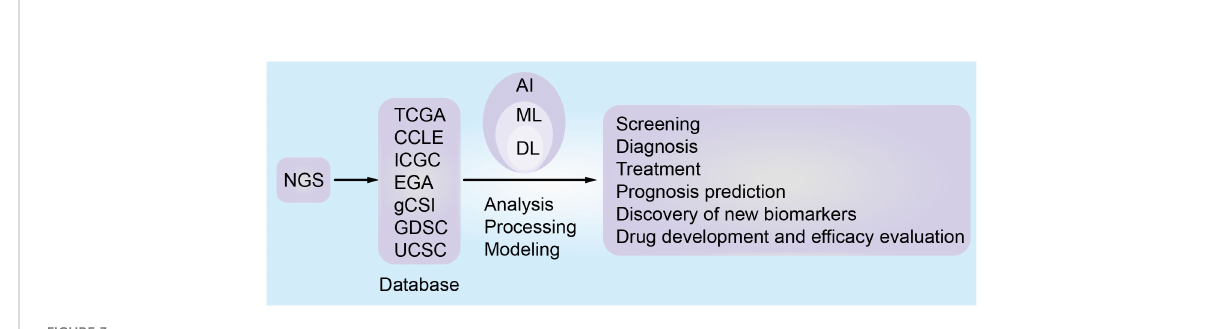
FIGURE 3 The role of arti fi cial intelligence based on omics database in tumor precision medicine.